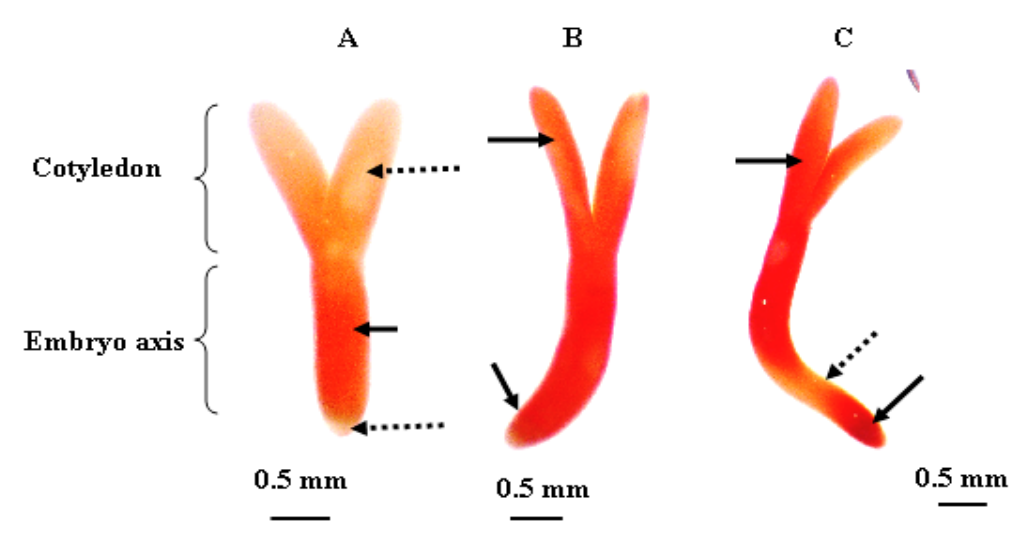
Fig. 3. Histochemical localization of the TTC reduction in: (A) embryo isolated from salt imbibed seeds (B) water im- bibed seeds (C) germinated embryo. The continuous arrows indicate high respiratory activity and the discontinuous arrows indicate low respiratory activity